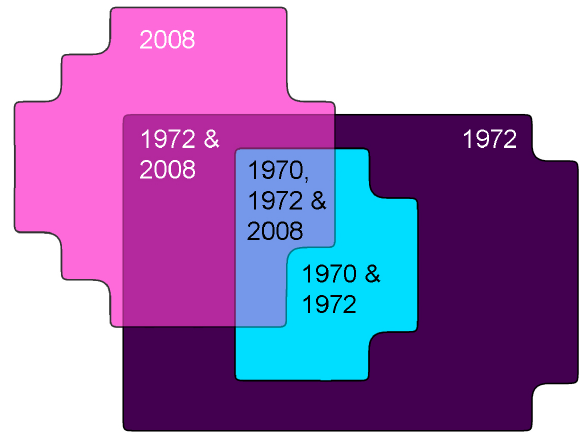
Figure 3. Area proportional Euler diagram for the total number of species found on Surtsey in 1970, 1972 and 2008. Each polygon in- dicates a total species number for a given year: 1970 = 17, 1972 = 72, 2008 = 38; the intersections indicate the species in